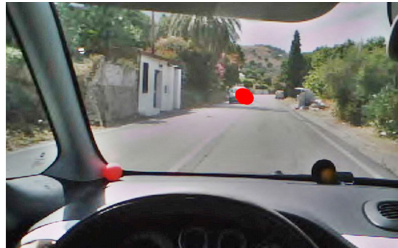
Figure 4. The vehicle coming in the opposite direction, without other stimuli, is seen by the driver